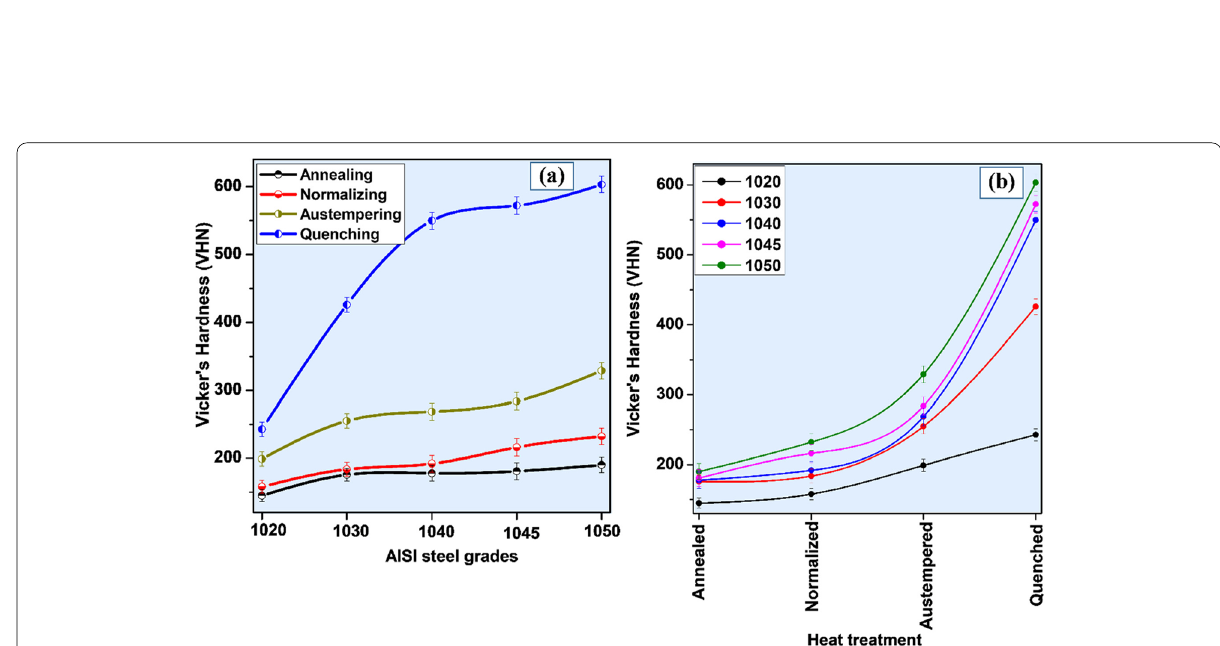
Fig. 6 Micro Vickers hardness profile of all plain carbon steels after various